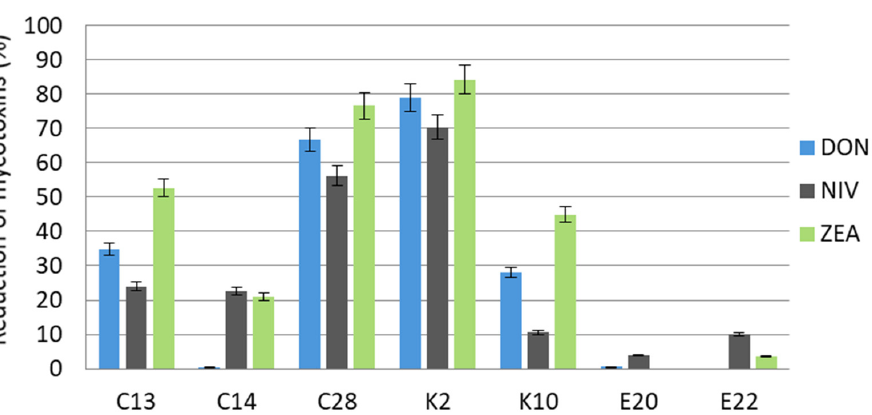
Figure 3. Reduction of deoxynivalenol, nivalenol, and zearalenone produced by F. poae in wheat grain after a 14-day incubation with the test yeasts. C13, C14, C28, K2, K10, E20, E22—code numbers of the yeast species acc. to Table 3. Error bar represents the standard error.